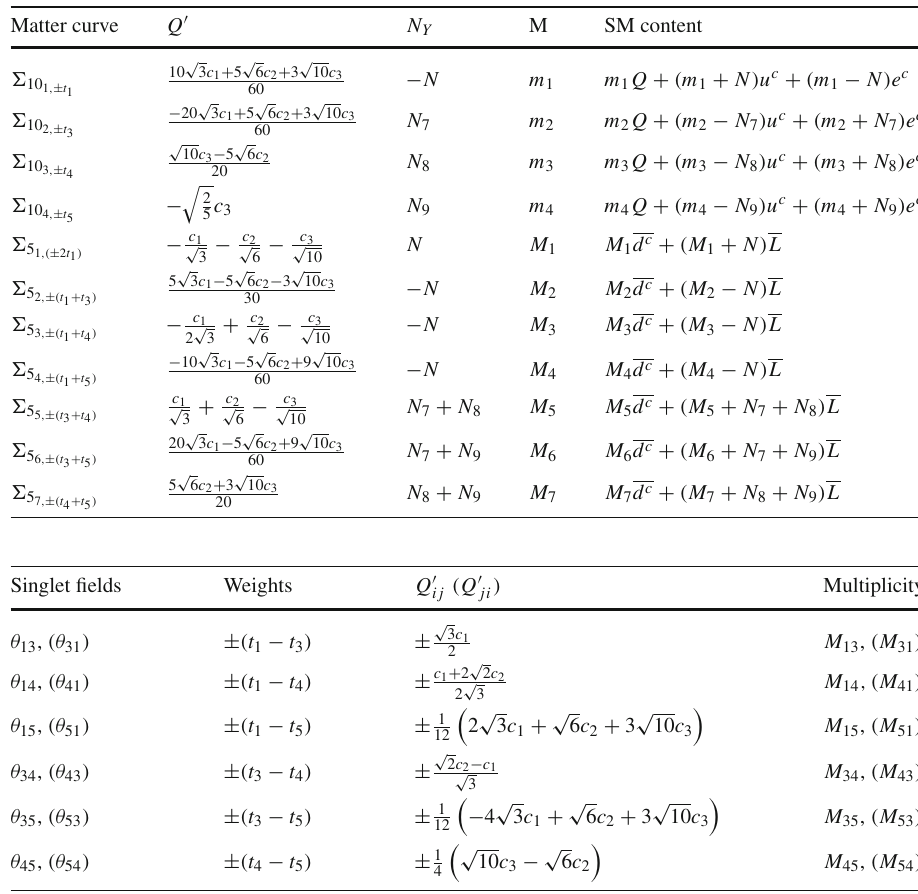
Matter curve Q (cid:2)